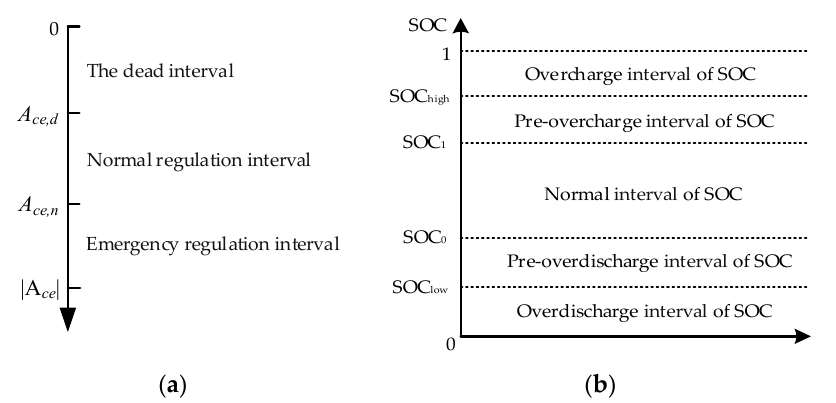
Figure 4. ( a ) Schematic diagram of the state partitions of ACE; ( b ) Schematic diagram of the state partitions of SOC.